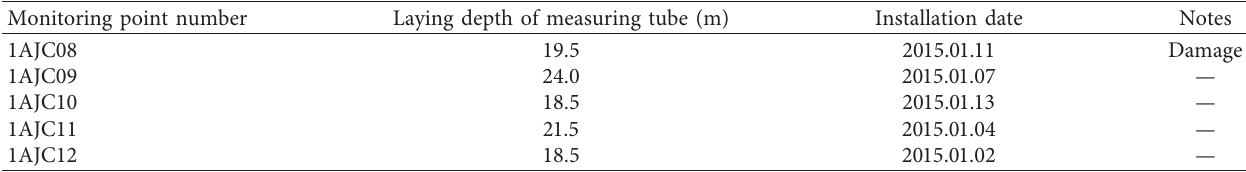
Table 1: Deep displacement monitoring point